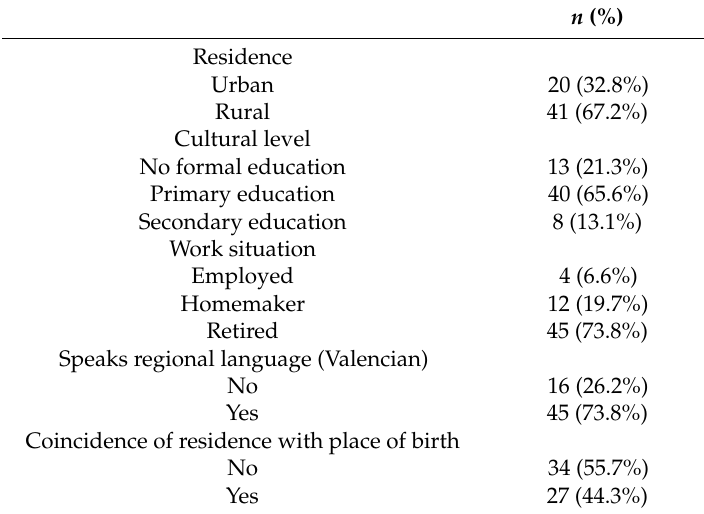
Table 1. Descriptors of the sociodemographic